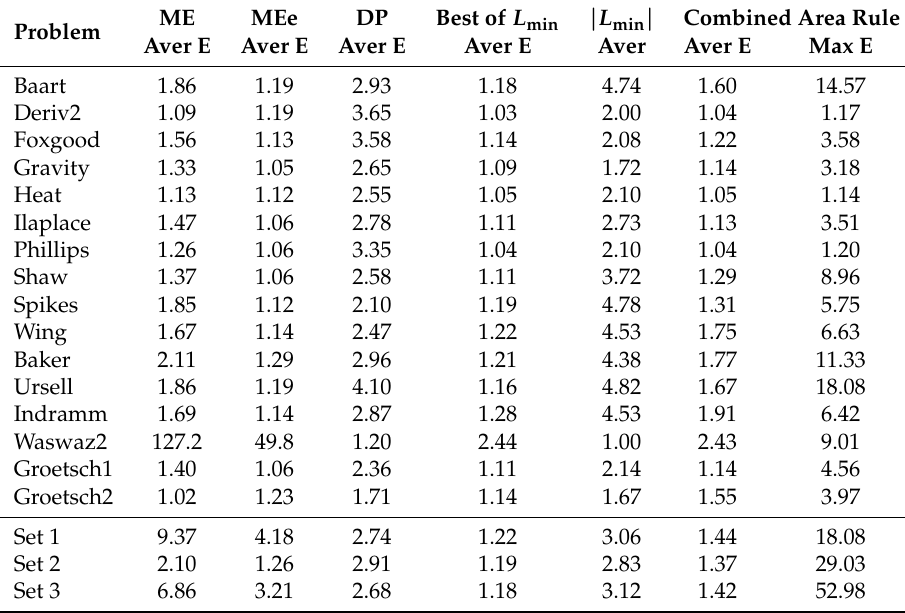
Table 2. Results of the numerical experiments, p = 2.